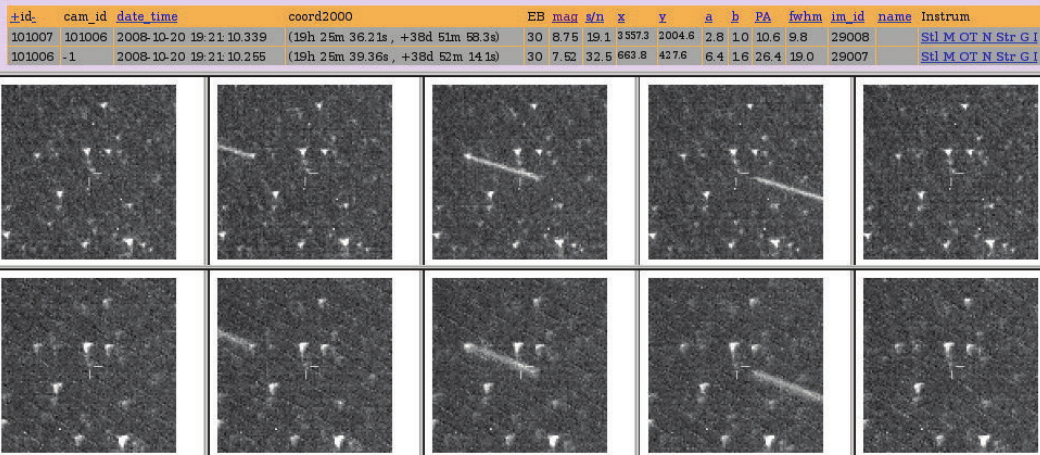
Figure 4: Debris of the American military satellite USA114Deb found via the web interface of the MASTER system. The top and bottom rows of the images are taken by the Northern and Southern cameras, respectively. The parallactic shift is apparent even to an unaided eye. The measured parallax implies a height of 4000 ± 200